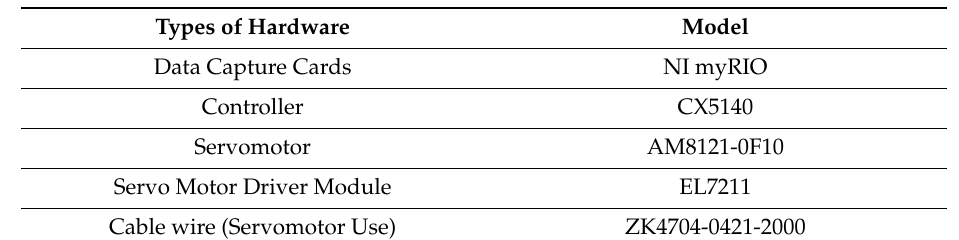
Figure 1. System structure. Table 1. Hardware model.